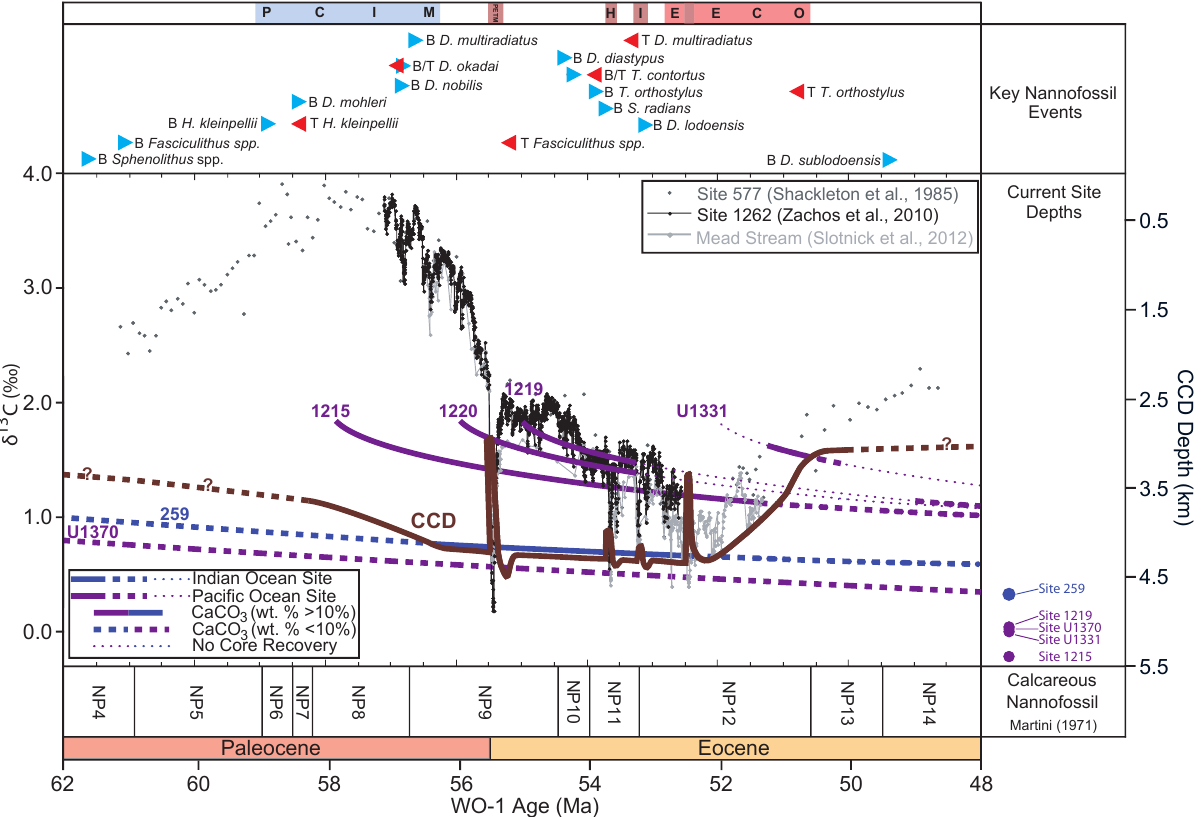
Figure 1. Bulk carbonate δ 13 C records and calcareous intervals for several locations placed onto a current timescale (Option 1; Westerhold et al., 2008). Stable isotope records include those at DSDP Site 577 (North Pacific; Shackleton et al., 1985), ODP Site 1262 (central Atlantic; Zachos et al., 2010) and Mead Stream (South Pacific; Slotnick et al., 2012). The subsidence curve for Site 259 (eastern Indian Ocean; blue) was adapted from (van Andel, 1975), while subsidence curves for Sites 1215, U1370, U1331, 1219, and 1220 (equatorial Pacific, purple) were adapted from various sources (Rea and Lyle, 2005; Leon-Rodriguez et al., 2010; Pälike et al., 2010). Plotted curves, when solid, indicate carbonate contents > 10%, but when dashed they indicate carbonate contents < 10%. Importantly, curves are lightly dotted when no data are available (such as for much of the early Eocene at Sites 1219 and 1220, as noted by Hancock et al., 2007). The dark-brown solid line denotes reconstructed and predicted CCD, consistent with carbonate content data and subsidence curves of sites from previous studies. The biozonal scheme adopted is that of Martini (1971). Blue and red triangles represent base and top occurrences of key calcareous nannofossils. Ages of calcareous nannofossil biohorizons are those proposed by Agnini et al. (2006, 2007) recalibrated using Option 1 of Westerhold et al. (2008). Hyperthermals, including PETM, H, I, and K/X, and longer-duration intervals (PCIM and EECO) derived from δ 13 C